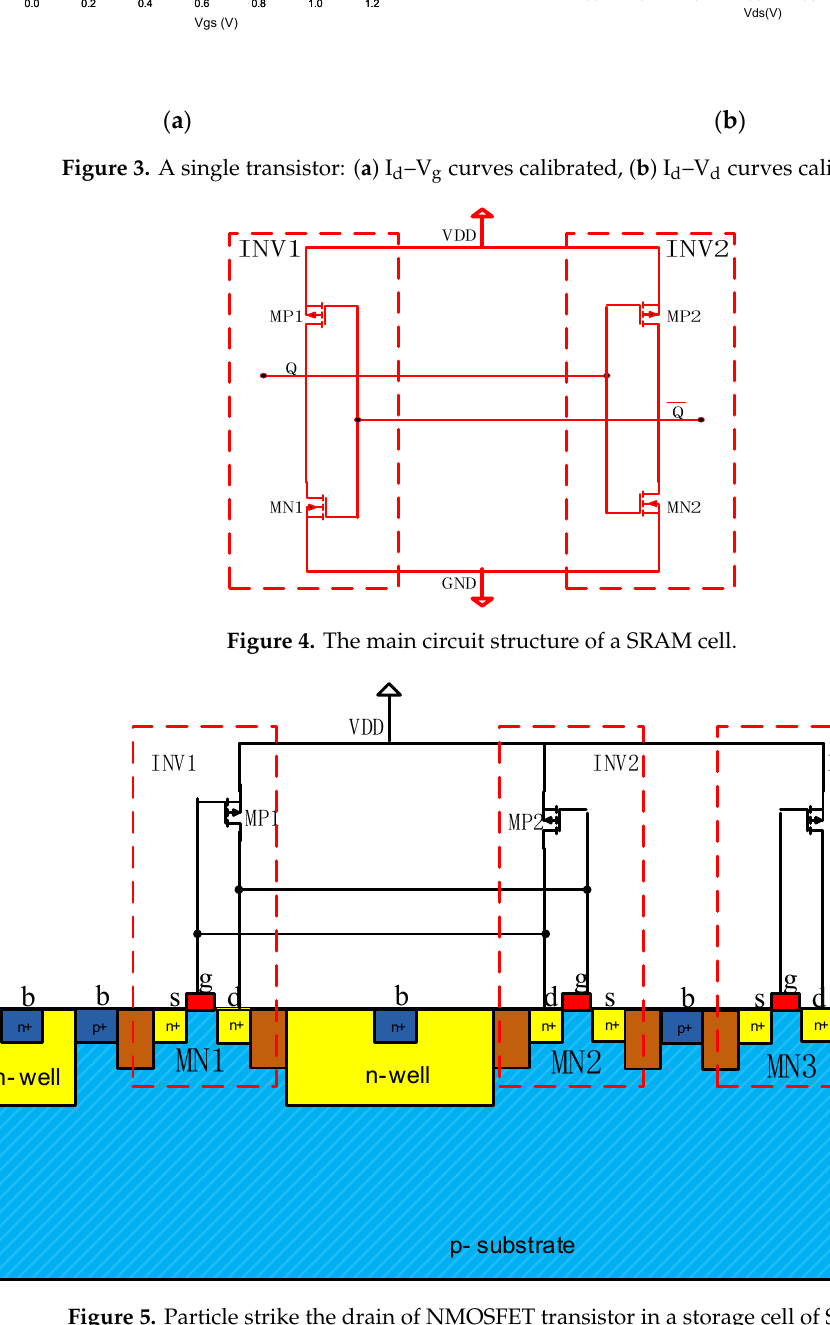
Figure 3. A single transistor: ( a ) I d –V g curves calibrated, ( b ) I d –V d curves calibrated.